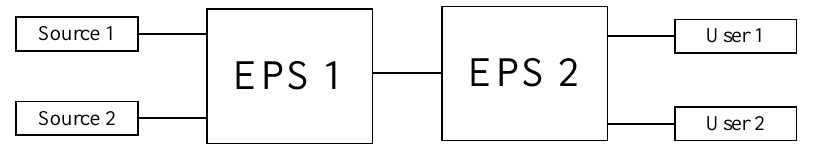
Figure 9. Diagram of the DMG testbed with two EPSs, two energy sources, and two